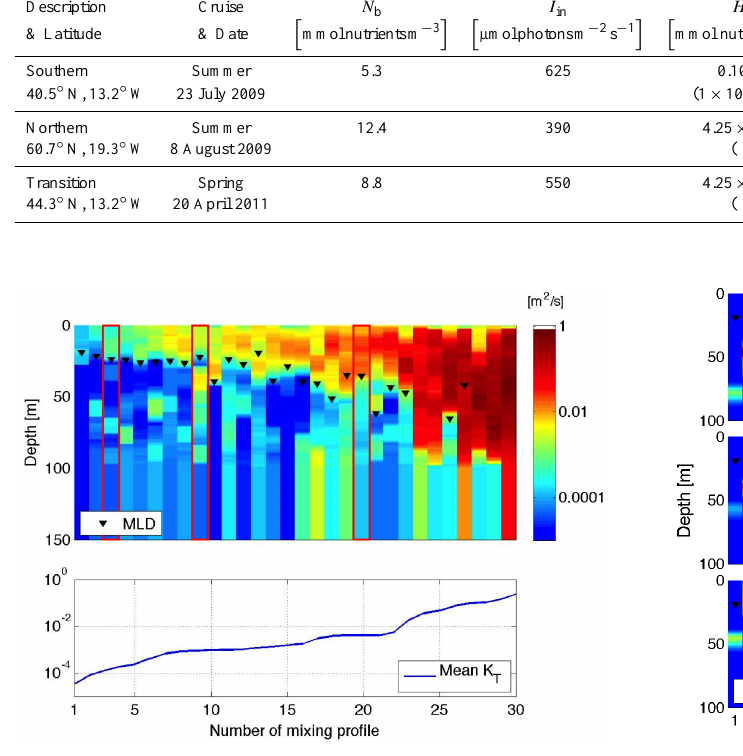
Fig. 8: Temporal evolution of (a) the relative change of the system per time step R and (b) the sum of squares S for the three reference stations. On the x-axis the time is given as the percentage of the total duration until the equilibrium is reached. The y-axis is in logarithmic scaling.